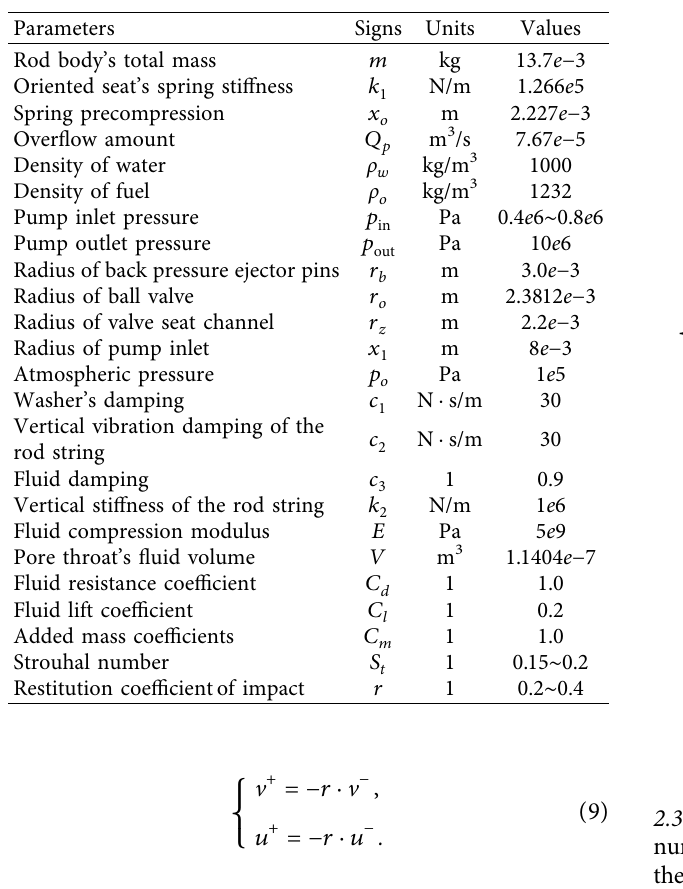
Figure 1: Schematic of the direct-acting relief valve and its corresponding 2-DOF physical model. Table 1: List of system